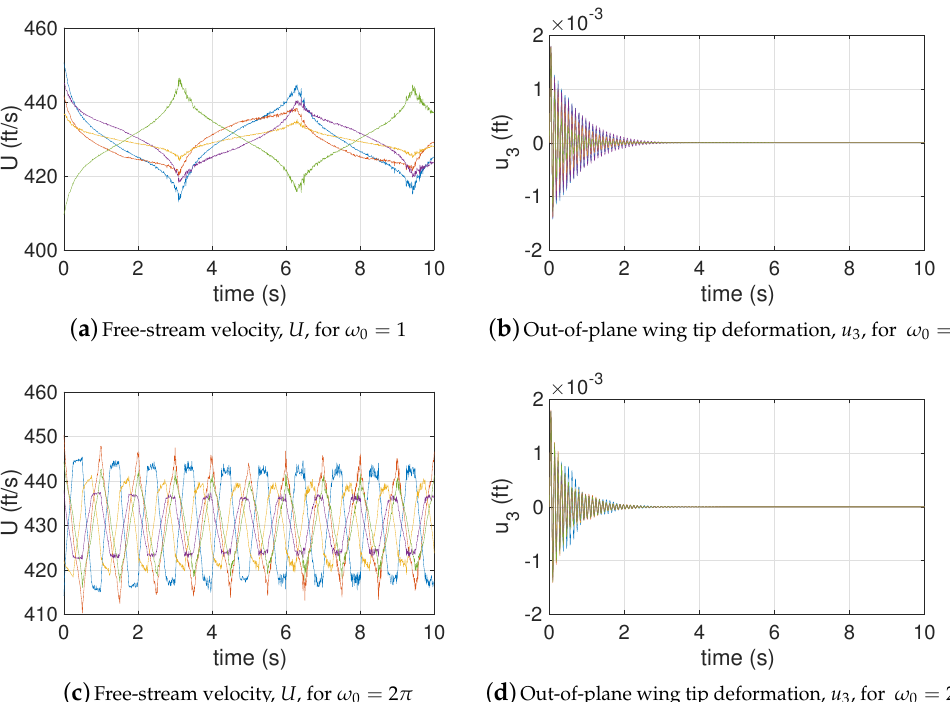
Figure 23. Goland Wing Oscillation with correlation function, r xx = Cos ( ω 0 t ) , ∆ = 0.1, and U ave = 430 ft/s.